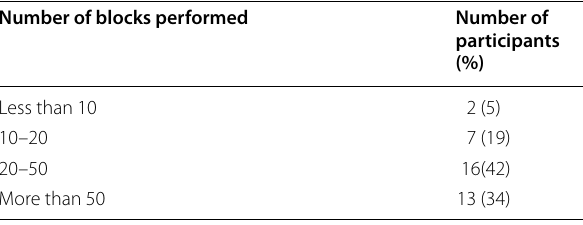
Table 1 Number of blocks previously performed by participants Number of blocks performed Number of